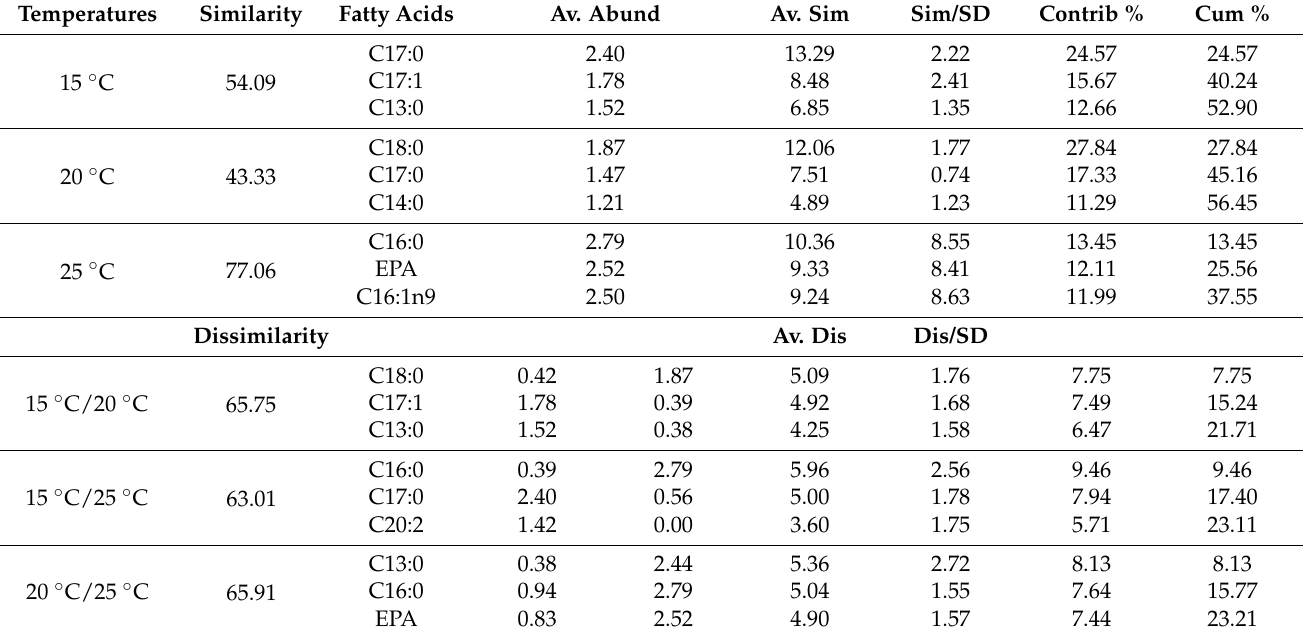
Table 4. SIMPER analyses showing the average similarity and dissimilarity among groups of samples, related with n-MDS